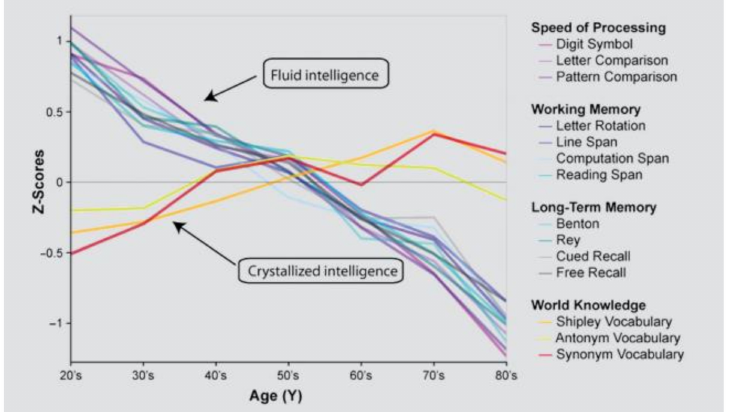
Figure 2. Cross-sectional aging data showing behavioral performance [40]. Cross-sectional aging data adapted from Reference [9]. showing behavioral performance on measures of speed of processing (i.e., Digit Symbol, Letter Comparison, Pattern Comparison), working memory (i.e., Letter rotation, Line span, Computation Span, Reading Span), long-term memory (i.e., Benton, Rey, Cued Recall, Free Recall), and world knowledge (i.e., Shipley Vocabulary, Antonym Vocabulary, Synonym Vo- cabulary). Almost all measures of cognitive function (fluid intelligence) show a decline with age, except world knowledge (crystallized intelligence), which may even show some improvement. Repro- duced with permission of the publisher; from Park DC, Bischof GN. The aging mind: Neuroplasticity in response to cognitive training. Dialogues Clin Neurosci. 2013;15(1):109–119 Copyright © 2021